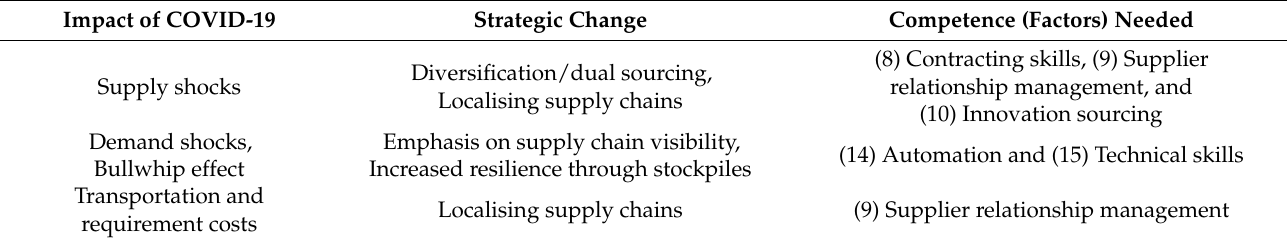
Table 4. Connecting COVID-19 impacts with strategic changes and essential